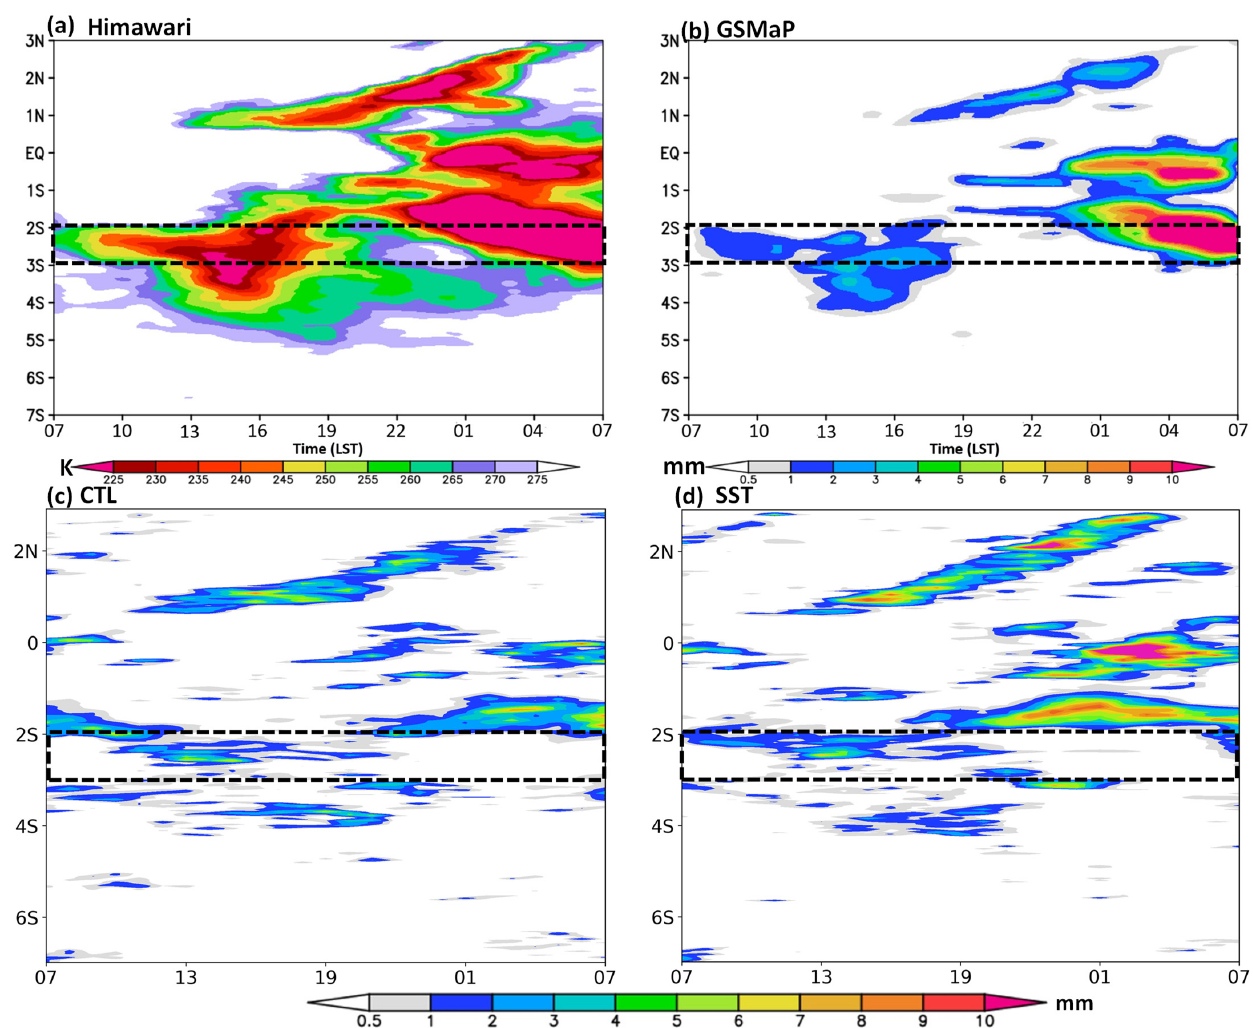
Figure 7. Latitude–time Hovmöller diagram averaged over 120° E–121° E (i.e., the Luwu region) from 13 to 14 July 2020 for ( a ) blackbody temperature (TBB) using Himawari satellite data; ( b ) precipitation observed by the GSMaP satellite; ( c ) precipitation simulated in the CTL run; ( d ) precipitation simulated in the updated SST run. The black dashed box indicates the Luwu region (2° S–3° S).